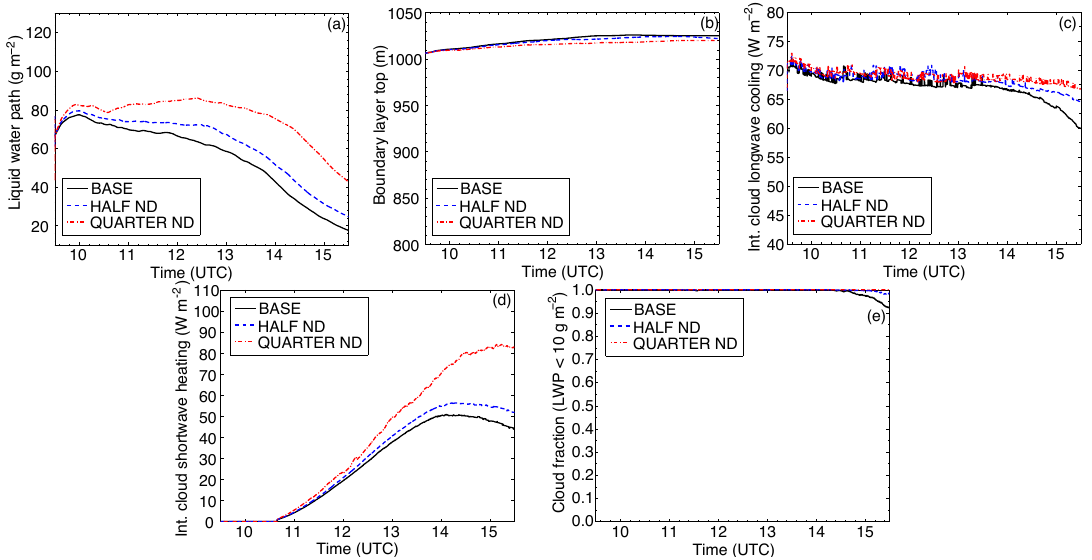
Fig. 8. LES output showing STBL response for changes in aerosol and cloud droplet concentrations. Domain averaged and vertically inte- grated time series of quantities are shown.